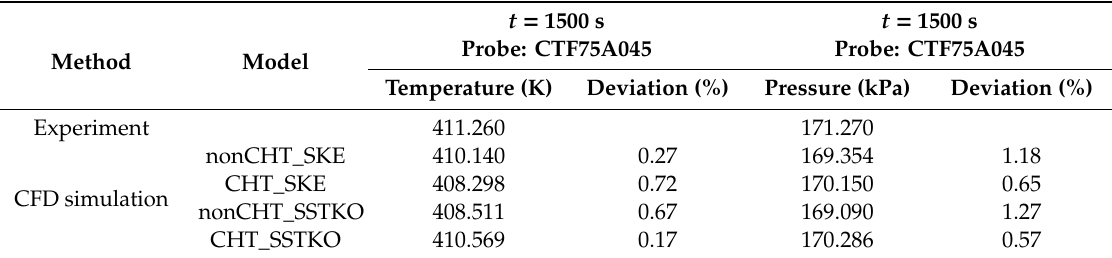
Table 5. Simulation model deviation from the measurement: e ff ect of flat bars.